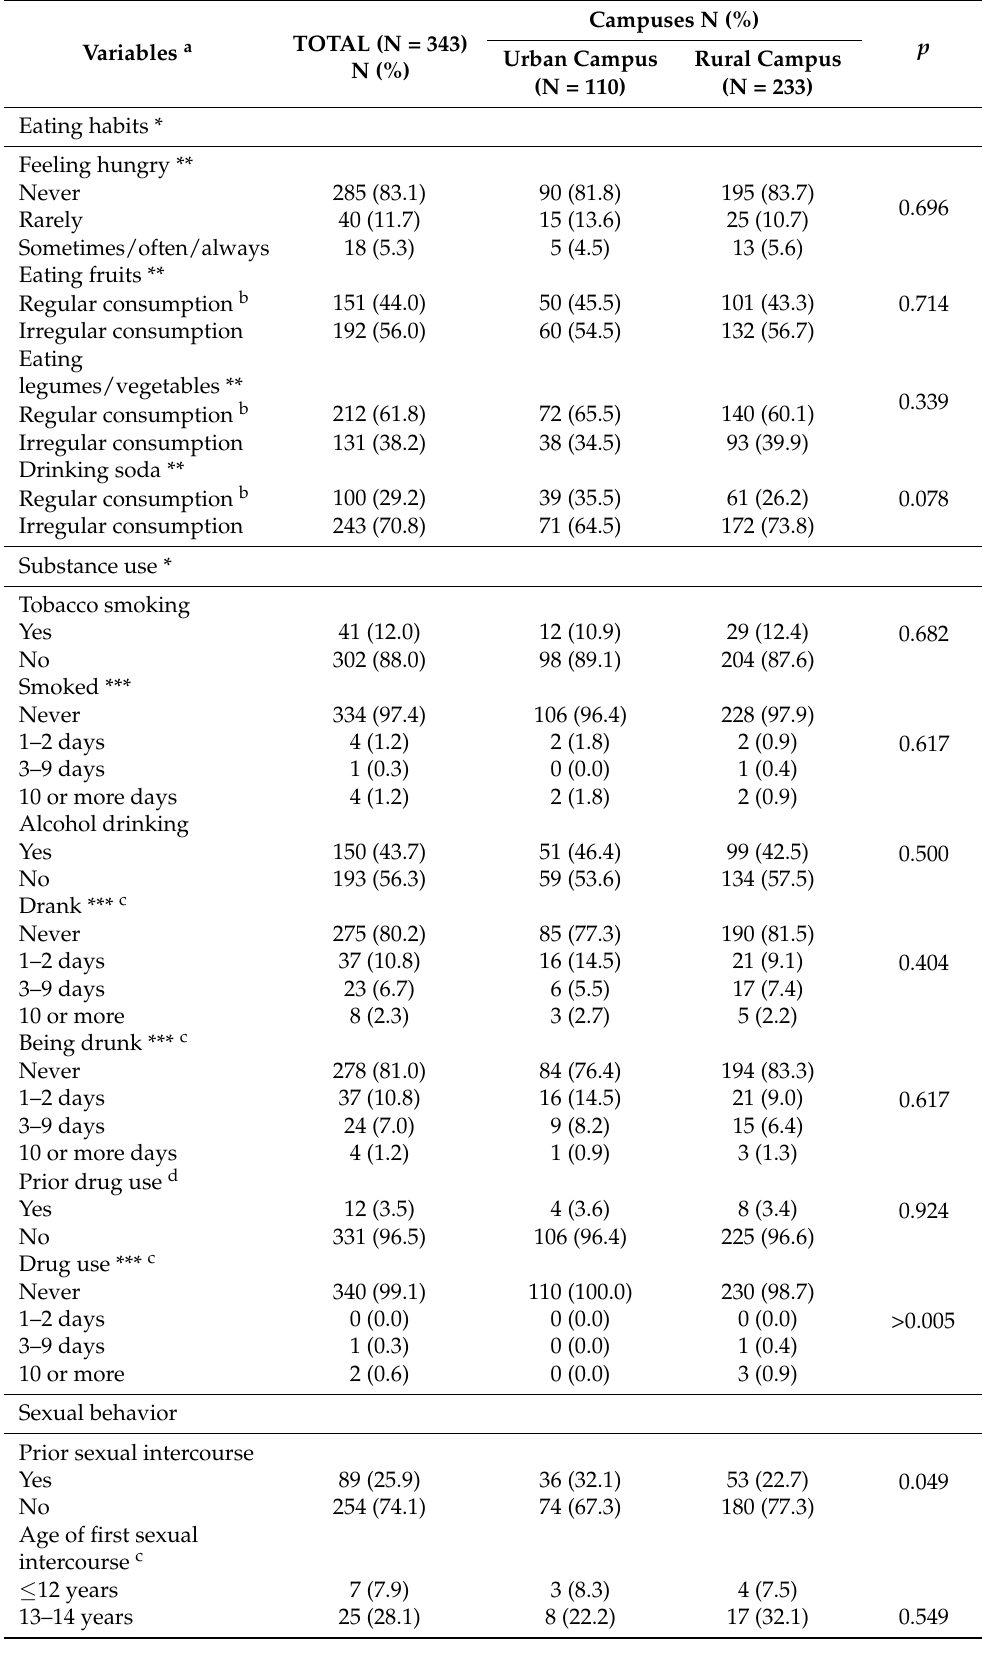
Table 2. Depressive symptoms, behavioral habits, and QoL in the sample, stratified by